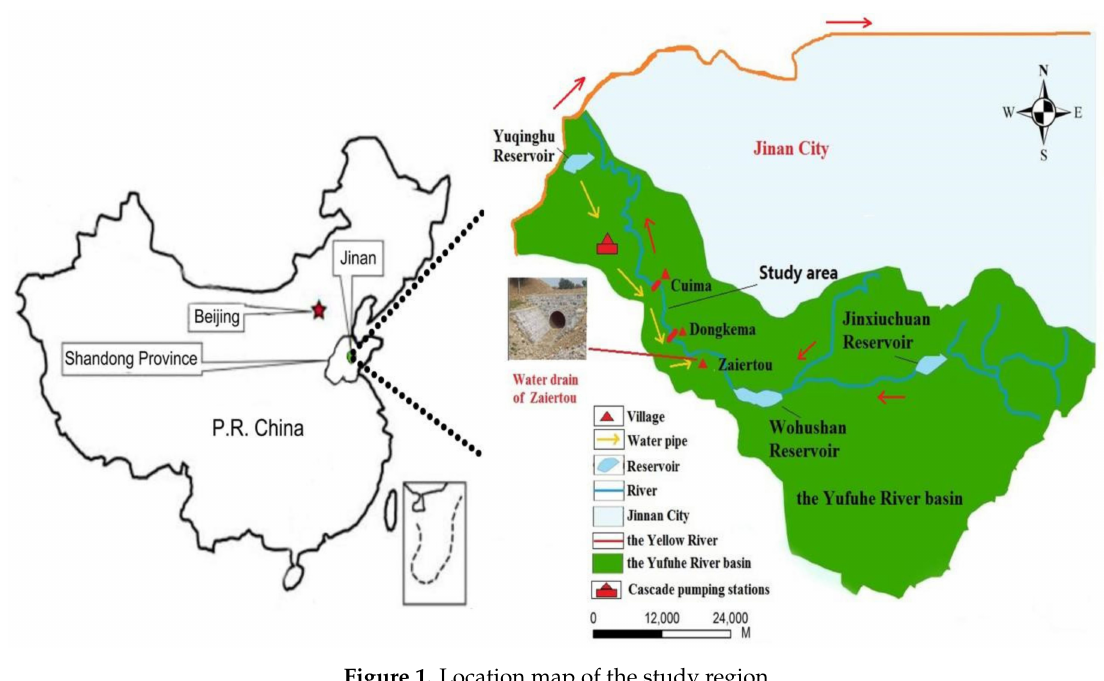
Figure 1. Location map of the study region.